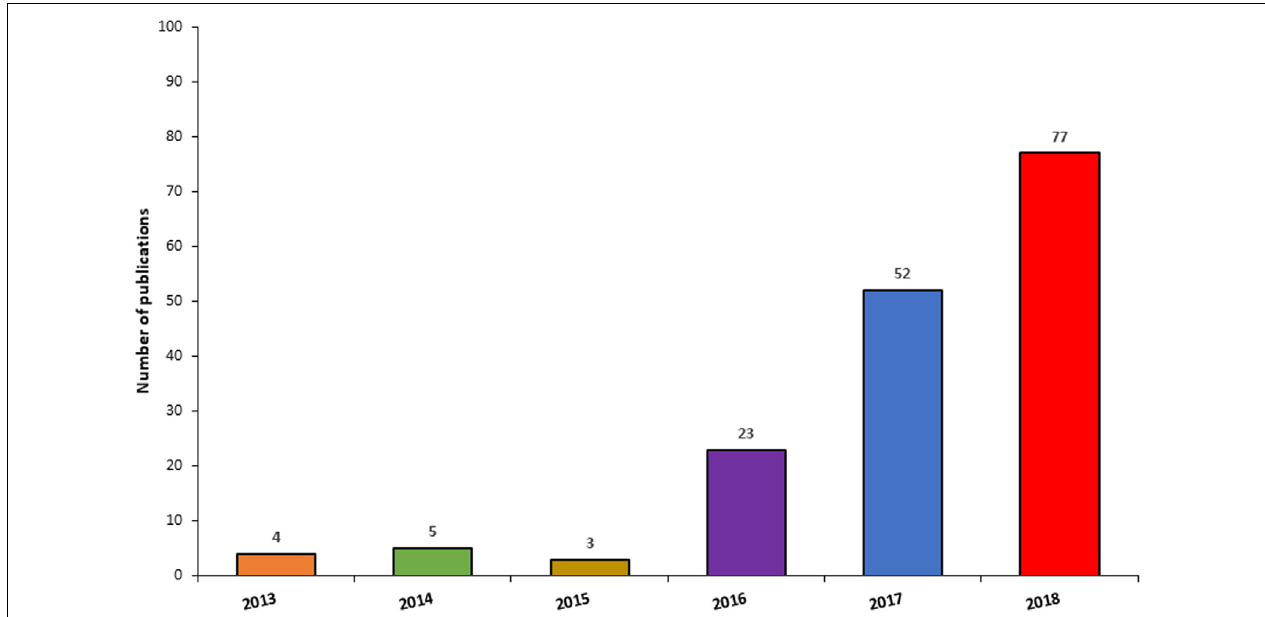
FIGURE 6 | Frequency of publications reporting the use of CNS organoids by year. The chart illustrates a surge in publications involving the use of CNS organoids, between 2014 and 2018.